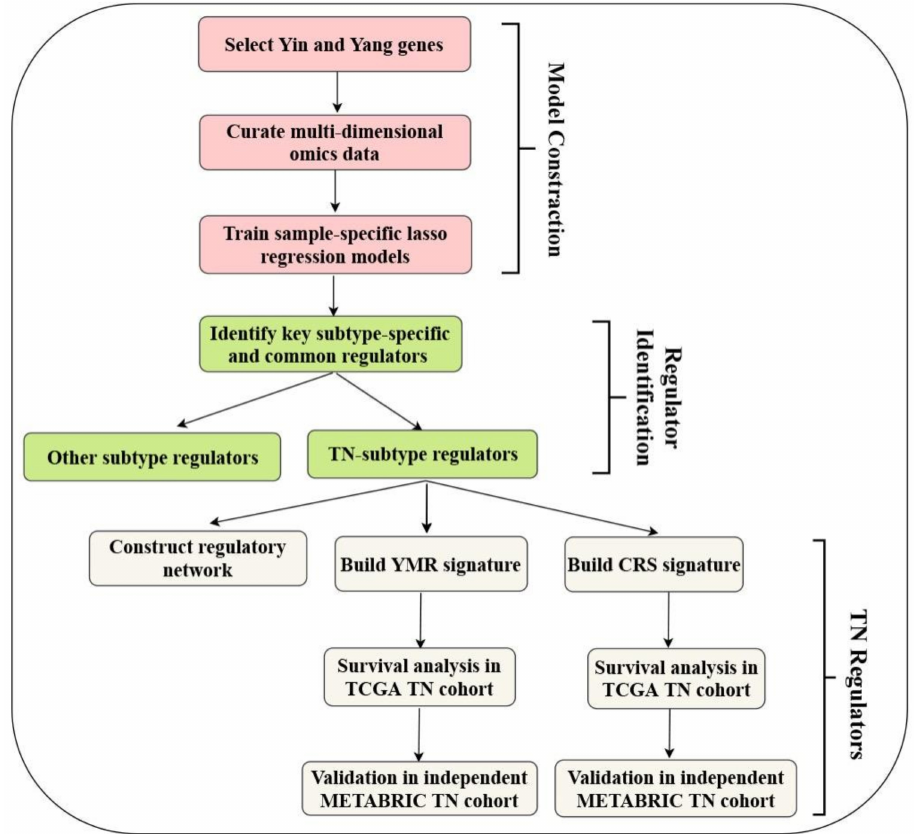
Figure 1. Study design. This study included three major parts. The first was to construct sample-specific models. Key regulators in different breast cancer subtypes were then identified from the models. Finally, we focused our follow-up exploration on the regulators in the TN